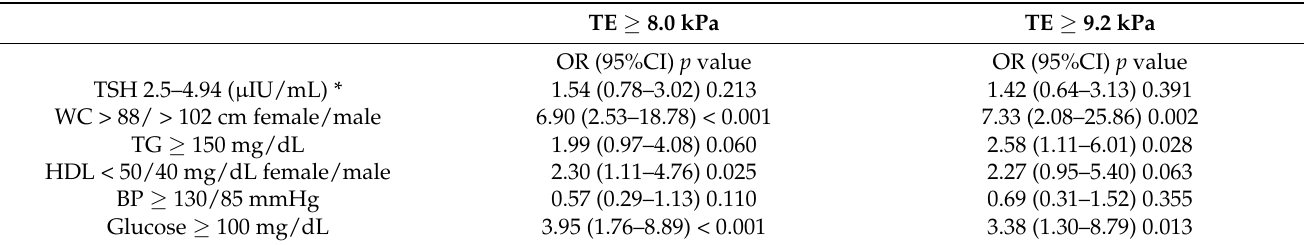
Table 7. Multivariate analysis of risk of liver fibrosis using different transient elastography cut-offs as dependent variables in low-normal thyroid function (TSH 2.5–4.94 µ IU/mL) vs. strict-normal thyroid function (TSH < 2.5 µ IU/mL). Multivariate logistic regression models adjusted for all the different parameters of